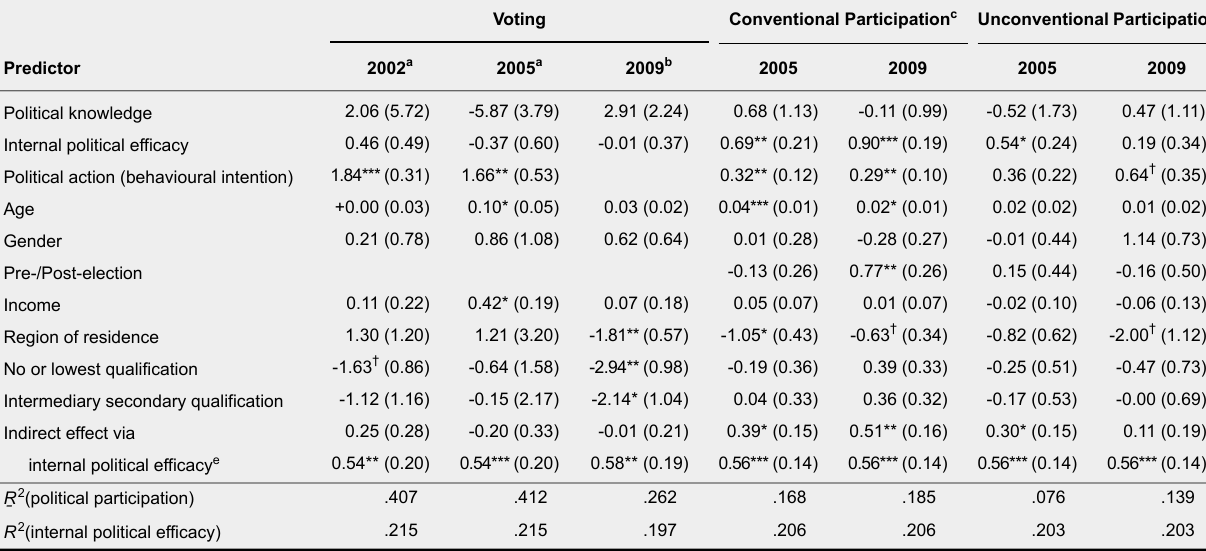
Longitudinal Mediated Regression Analyses (Dependent Variables: Political Participation)